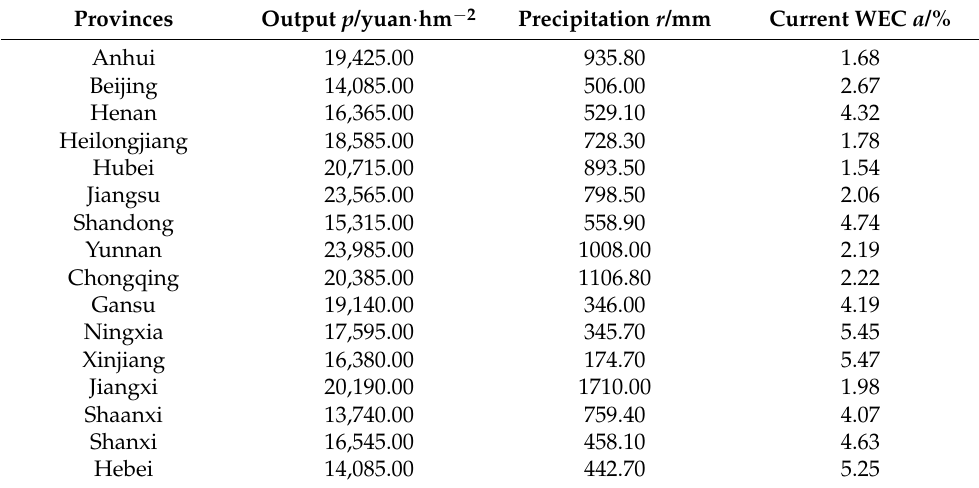
Table 4. WEC, the value of precipitation, and output per unit area of each province.